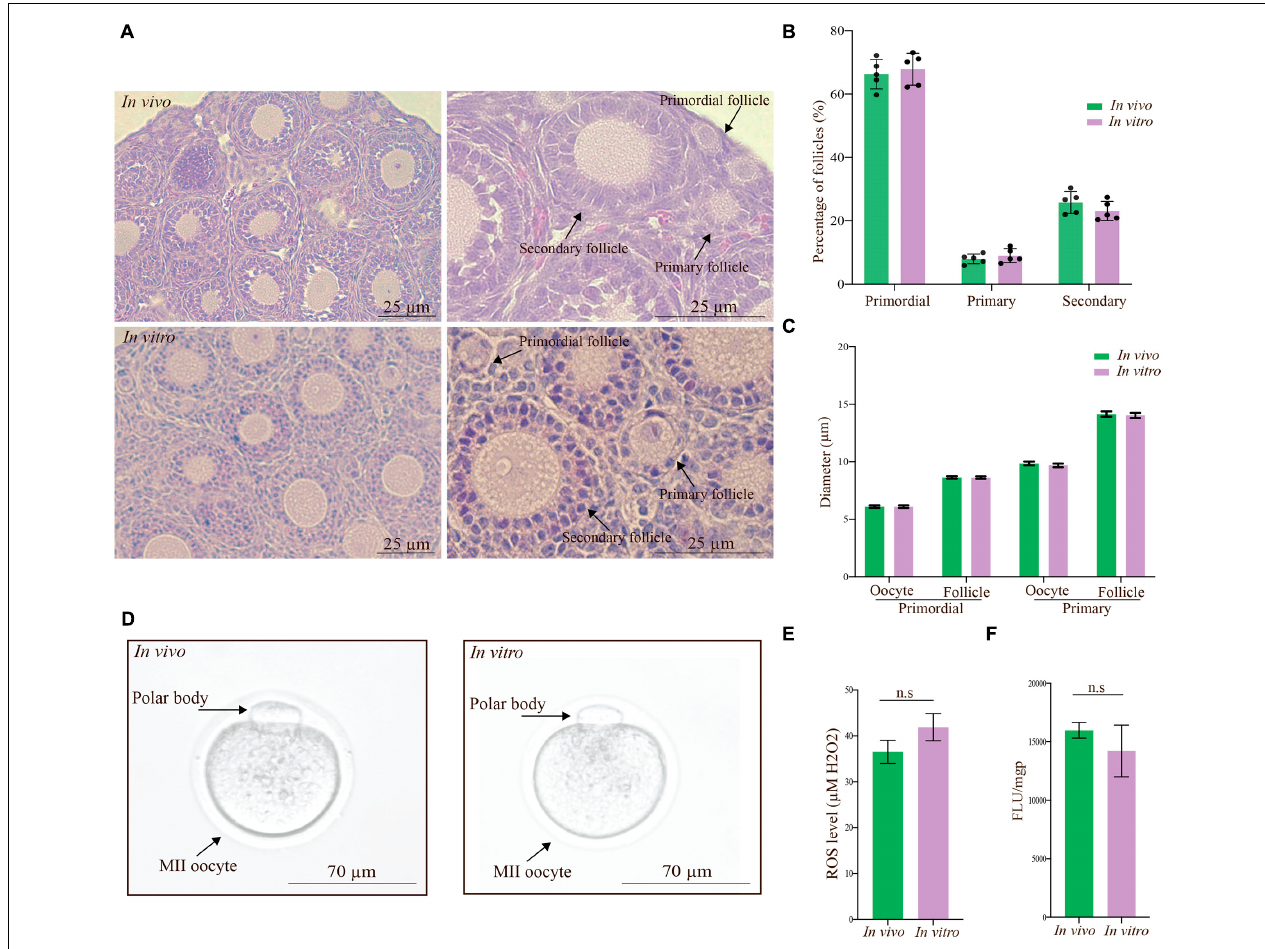
FIGURE 2 | Evaluation of ovaries and metaphase II (MII) oocytes based on morphology, development, and mitochondrial function. (A) Photomicrographs show the ovaries in the in vivo and in vitro groups stained with hematoxylin and eosin at low and high magnifications. The integrity and structural organization of ovaries from the in vivo group were similar to those of ovaries from the in vitro group. Scale bar: 25 µ m. (B) The percentage of follicles in each developmental stage was calculated based on the number of normal follicles from the in vivo ( n = 5 ovaries, n = 1,314 primordial, n = 170 primary, and n = 440 secondary follicles) and in vitro ( n = 5 ovaries, n = 1,152 primordial, n = 134 primary, and n = 438 secondary follicles) groups. There was no significant difference between the in vivo and in vitro groups in each follicle developmental stage. Values are given as the mean ± standard error (SE). (C) The diameter of oocytes and follicles in primordial and primary follicle stages. There was no significant difference between the in vivo and in vitro groups. Values are given as the mean ± SE. (D) Representative photomicrographs of MII oocytes from the in vivo and in vitro groups. Alignment based on the morphology of MII oocytes derived under in vitro conditions with in vivo -derived MII oocytes was clear. Scale bar: 70 µ m. (E) Reactive oxygen species (ROS) levels in collected MII oocytes from the in vivo- and in vitro -matured groups. There was no significant difference between the groups. Values are given as the mean ± SE. (F) Uptake of the cationic carbocyanine dye JC-1 into the matrix and mitochondrial membrane potential of collected MII oocytes from the in vivo- and in vitro -matured groups. There was no significant difference between the groups. Values are given as the mean ±